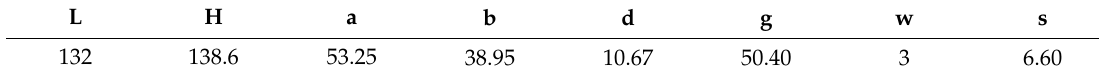
Figure 2. The layout of Antenna_1. Table 1. Geometrical parameter values of Antenna_1 in [mm].